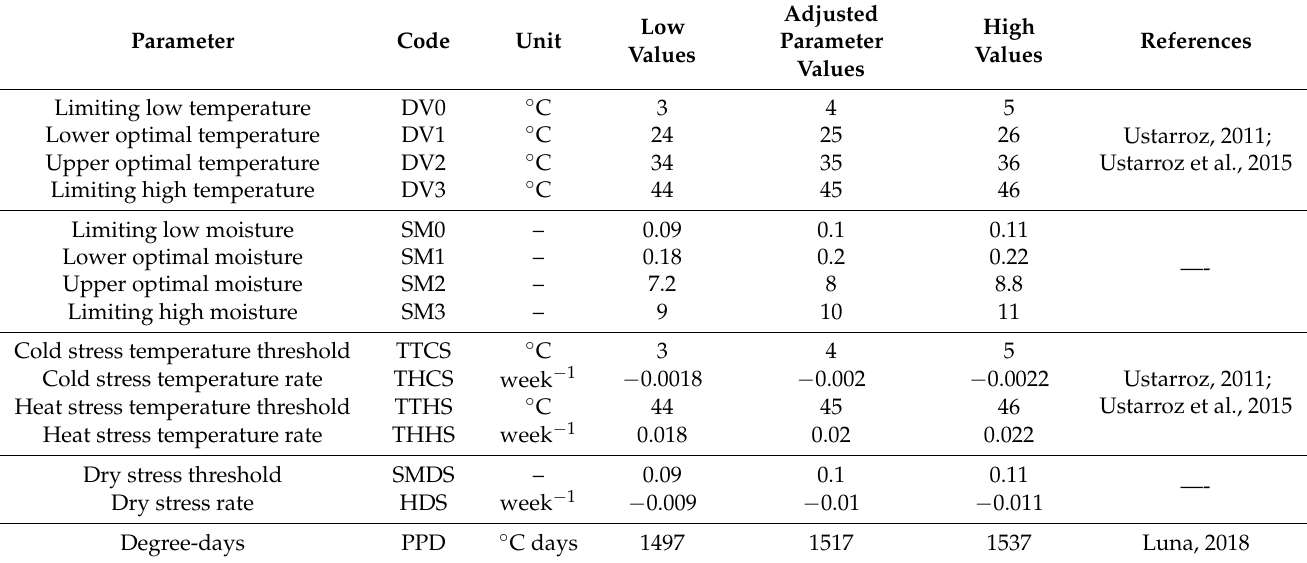
Table 1. Adjusted parameter values for modeling Urochloa panicoides . Proposed low and high values for the software included in the sensitivity analysis, using